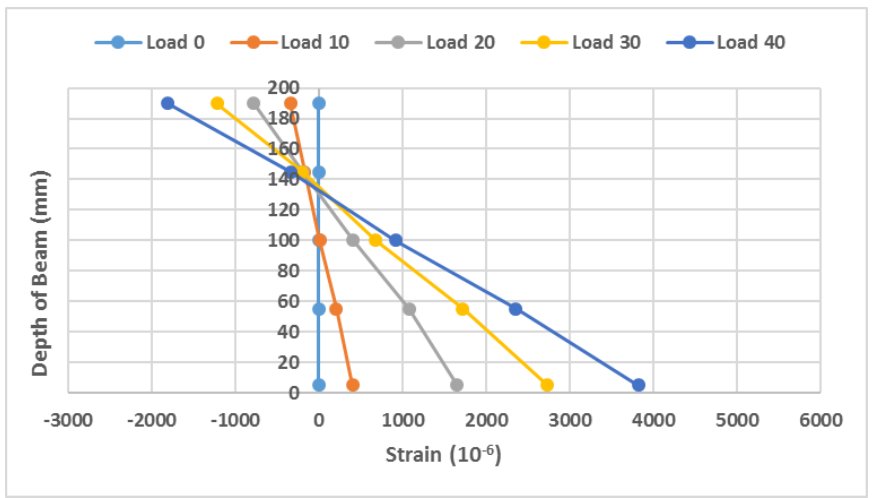
Figure 13. Depth of neutral axis for RA.